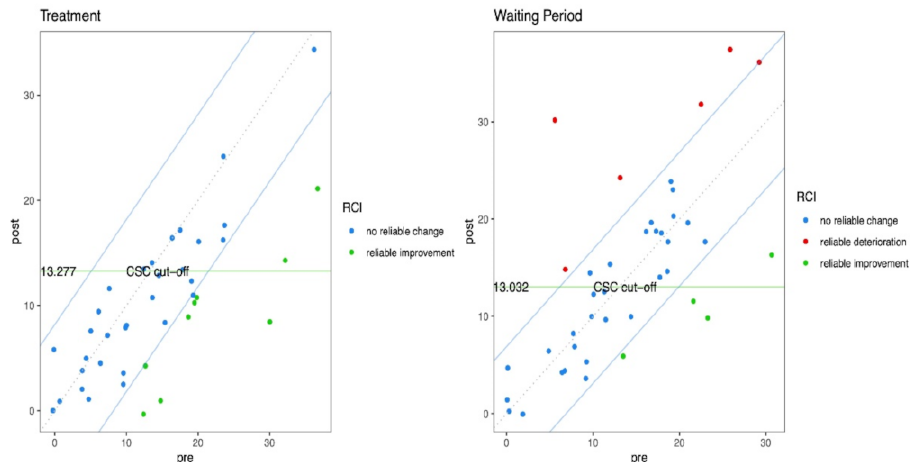
Figure 5. Jacobson plot depicting the 95% CI of the RCI between the blue lines and the CSC cutoff for pre- and post-test between the green lines. Blue dots represent participants who did not have a reliable change between pre and post measures. Red dots represent individuals who had a reliable deterioration between the two time points. Green dots are participants who showed a reliable improvement between the two measures. Green dots falling in the bottom-right section of the rectangle delimited by the green horizontal and vertical lines are participants with a reliable change plus a CSC. Green dots falling in the bottom-left section of the rectangle delimited by the green horizontal, and vertical lines are participants who already have high scores to show a CSC. RCI: reliable change index; CSC: clinically significant